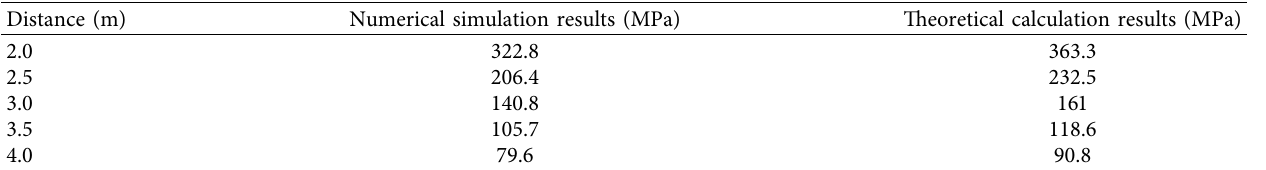
Figure 6: von Mises equivalent stress distribution nephogram at different times. (a) t � 2ms. (b) t � 4 ms. (c) t � 6 ms. (d) t � 8 Table 5: Peak pressure simulation and calculation results.